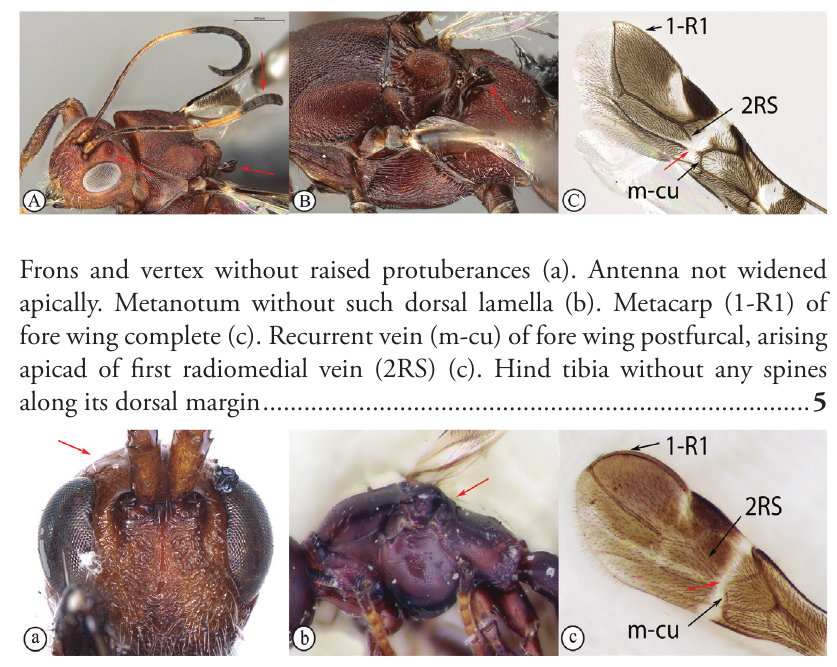
Frons and vertex laterally with distinctly raised protuberances (A). Antenna subclavate, widened and dorso-ventrally flattened apically (A). Metanotum with a long dorsal, laterally compressed lamella in form of inverted triangle (A, B). Metacarp (1-R1) of fore wing ephemeral in distal half (C). Recurrent vein (m-cu) of fore wing antefurcal, arising basad of first radiomedial vein (2RS) (C). Hind tibia with several short and thick spines along its dorsal margin ........................................................................ Spathioplites Fischer